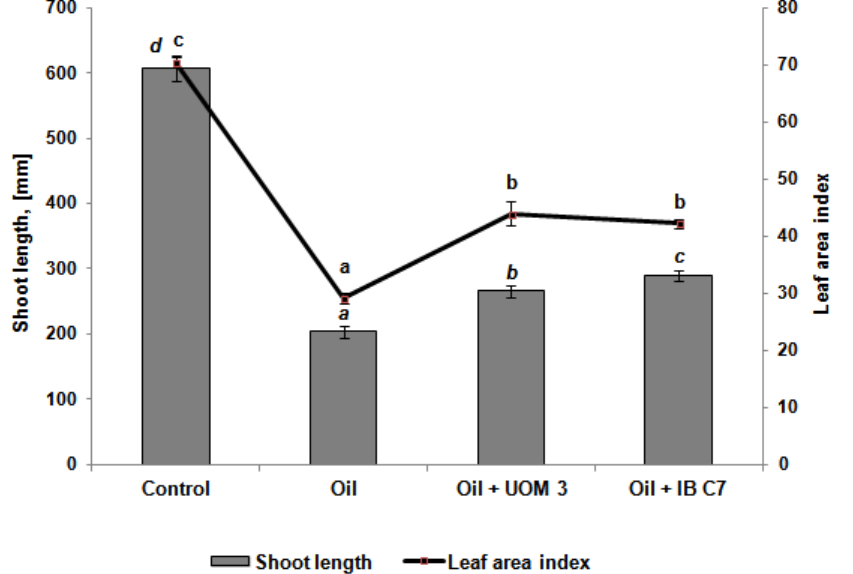
Figure 2. Shoot length and leaf area index of barley plants 34 days after germination. UOM 3 and IB C7, variants of experiments with introduction of Enterobacter sp. UOM 3 and p. hunanensis IB C7, respectively. Statistically different means values for each indicator ( n = 50) are marked with different letters ( p ≤ 0.05).